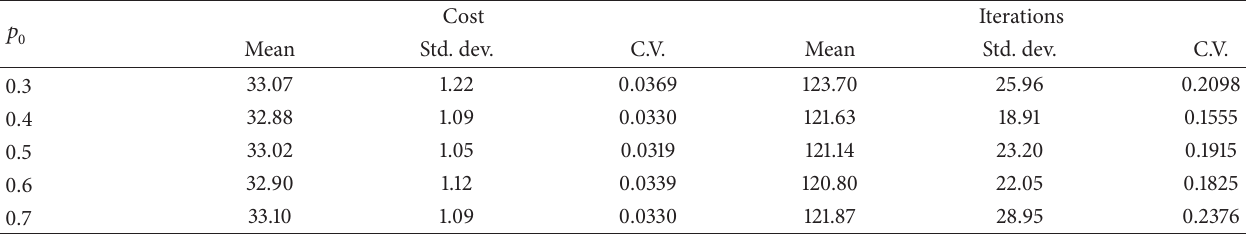
Table 6: Results with different 𝑝 0 (cost: million CNY; iterations: